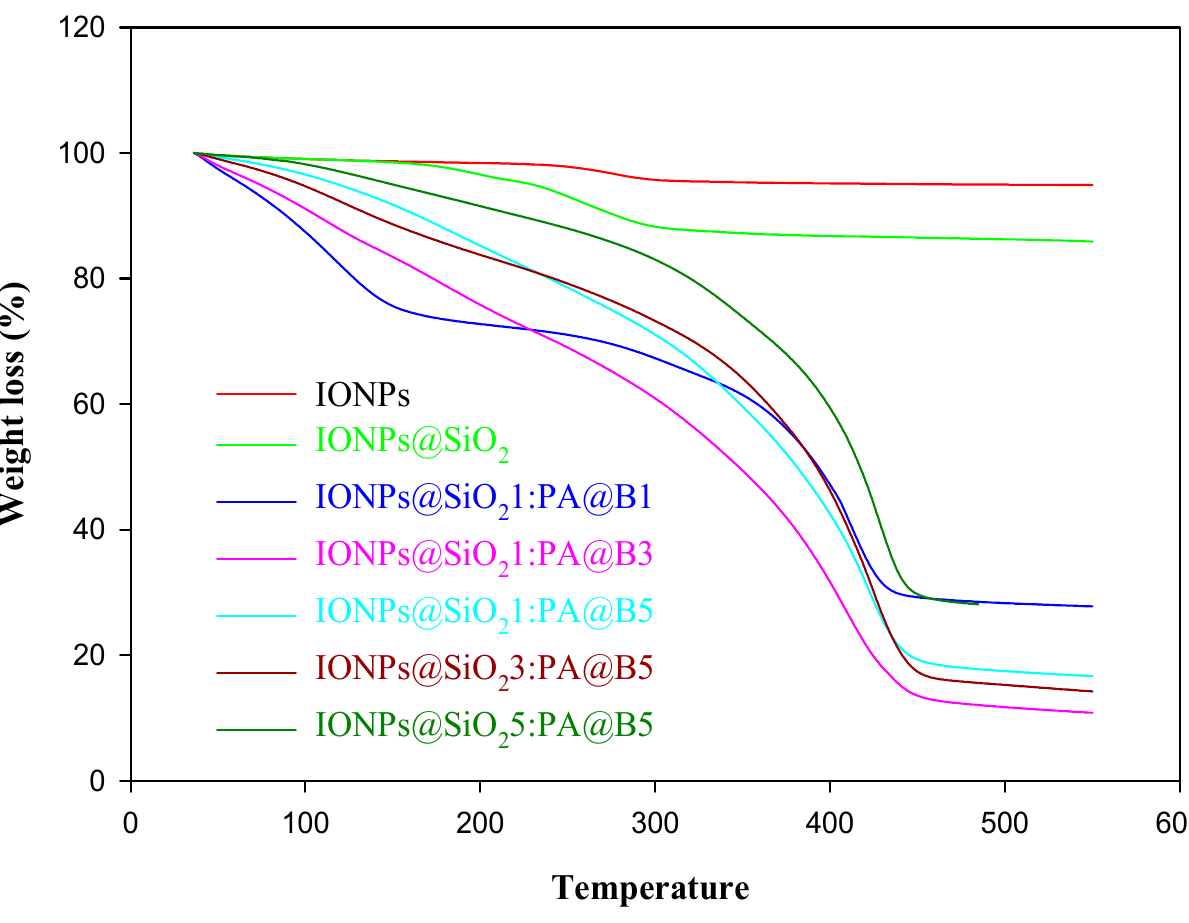
Figure 4. Thermogravimetric analysis of pure IONPs, IONPs@SiO 2 , and the fabricated MCM-PA@B with different ratios of IONPs@SiO 2 and PA@B.